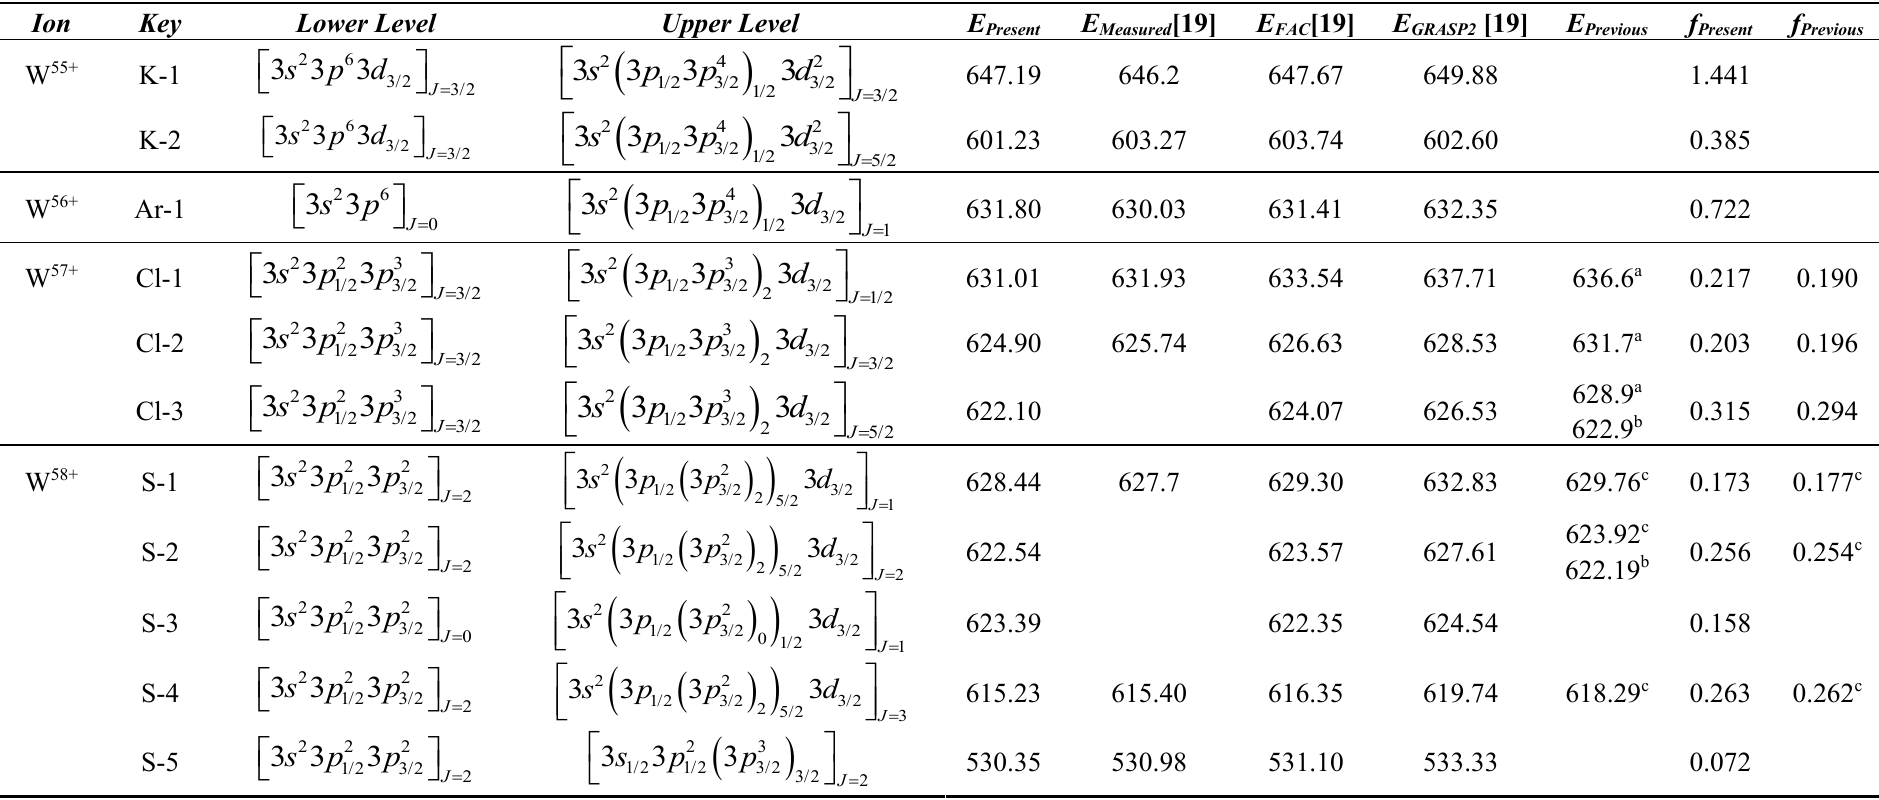
Table 6. Comparison of our calculated excitation energies (in eV) and the oscillator strengths ( f ) of the transitions in K-like W 55+ through Ne-like W 64+ ions with the available measurements and the other theoretical